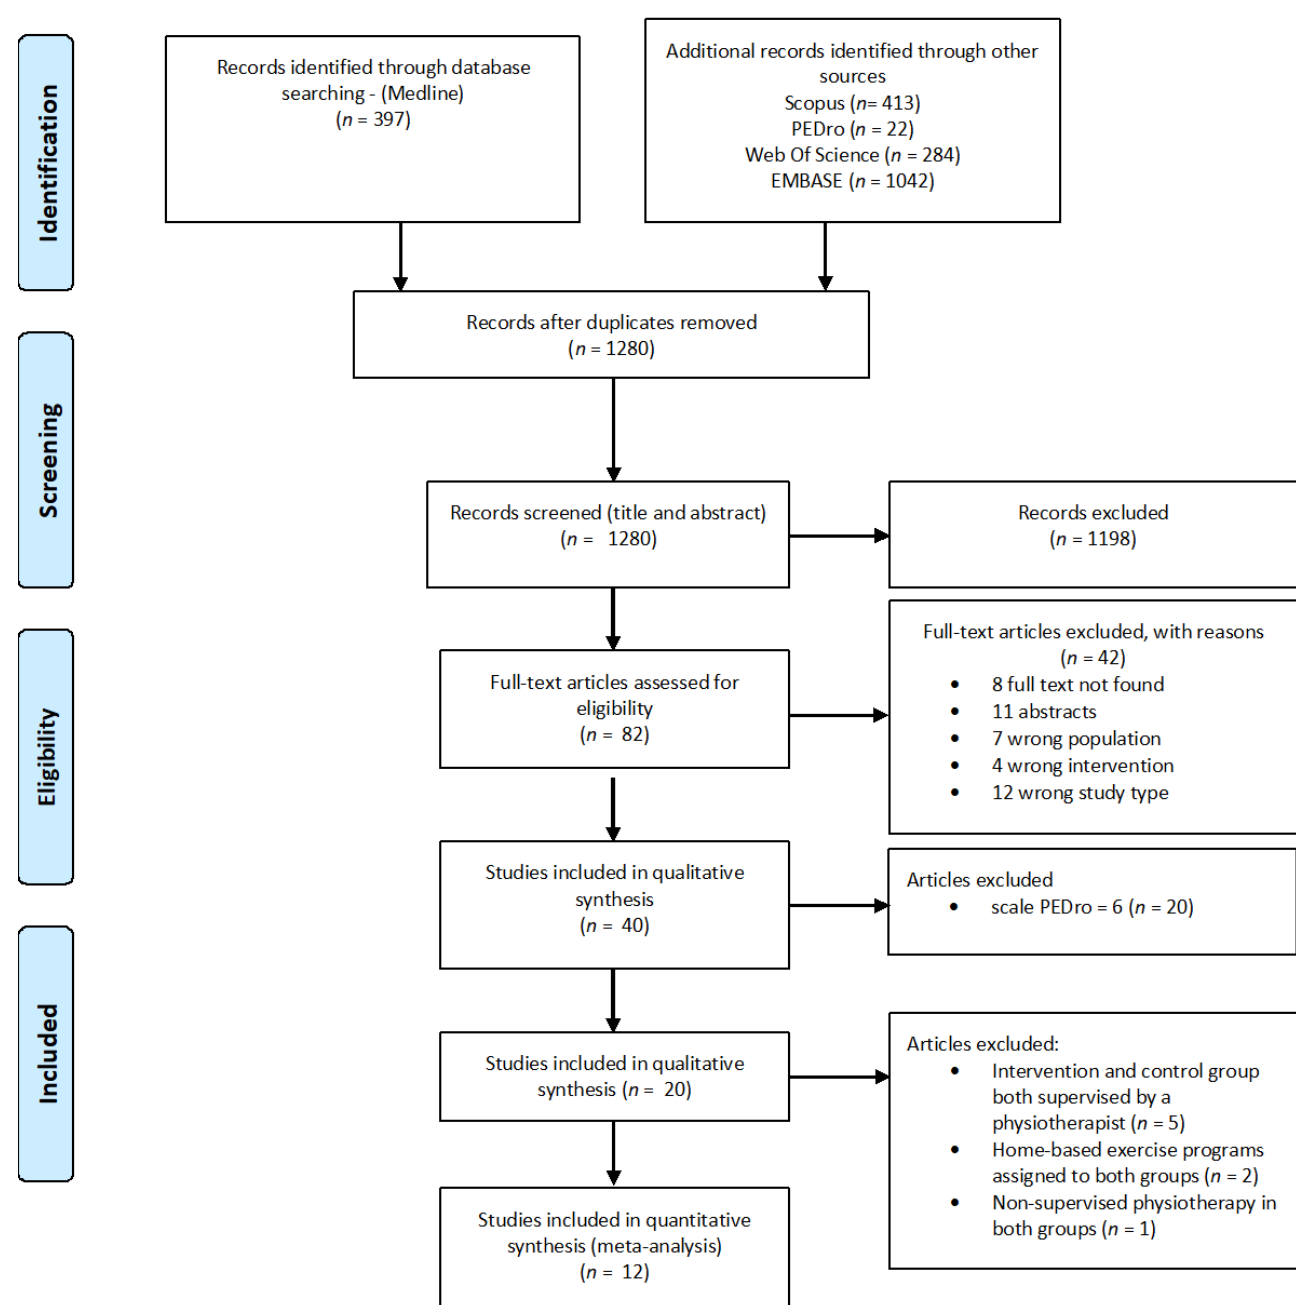
Figure 1. Prisma Flowchart.